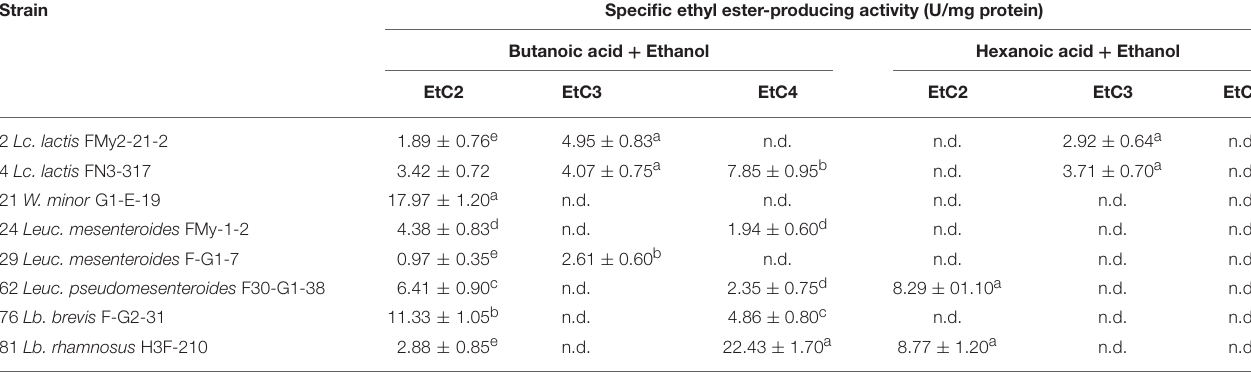
TABLE 6 | Specific activity for the production of fruity ethyl esters by selected LAB strains. Strain Specific ethyl ester-producing activity (U/mg protein) Butanoic acid +